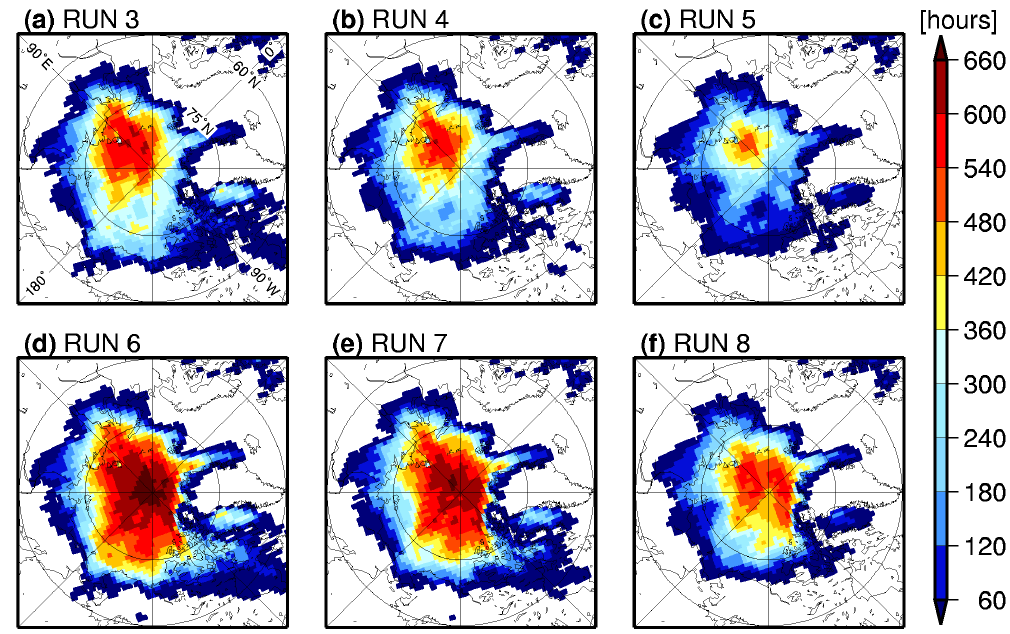
Fig. 6. Total hours of simulated episodes with surface ozone mixing ratios below 5nmolmol − 1 at each grid cell during April 2001: (a) Run 3, (b) Run 4, (c) Run 5, (d) Run 6, (e) Run 7, and (f) Run